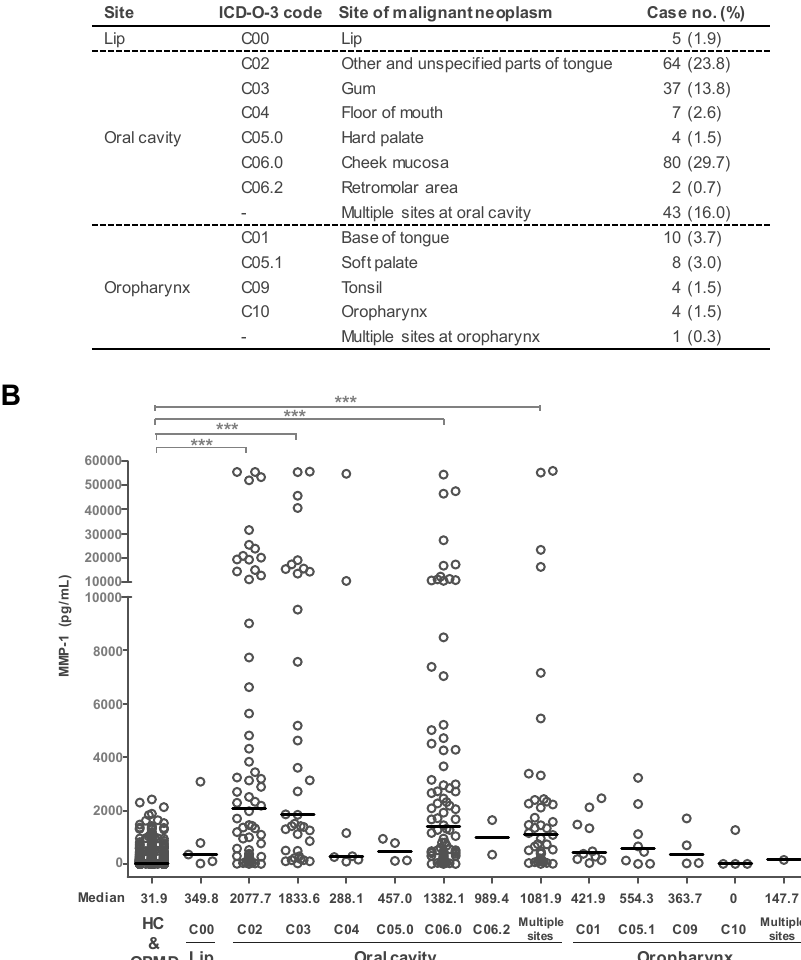
Figure 2. Di ff erential expression levels of salivary MMP-1 in OSCC and non-cancerous groups. ( A ) Clinical information and subgroups of OSCC ( n = 269) in this study. ( B ) Associations between salivary MMP-1 content in HC, OPMD, and OSCC with different tumor sites. *** p < 0.001. The median level of salivary MMP-1 (pg/mL) in each subgroup is shown for comparison.